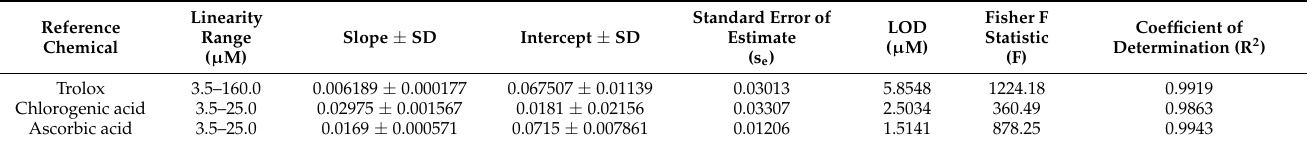
Figure 1. AgNPs absorption spectra measured spectrophotometrically in the range of 340–540 nm, obtained with increasing concentration of chlorogenic acid from the bottom to the top: 0; 3.5; 7.14; 10.71; 14.25; 17.85; 25 µM). Table 5. Linear regression parameters for the calibration curves of SNAPC method representing the absorbance measured at 423 nm vs. conc (µM) of reference chemicals.